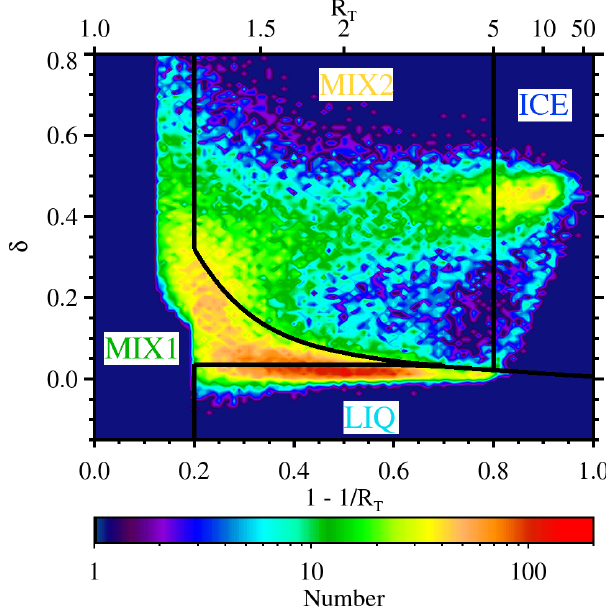
Fig. 2. Distribution of aerosol depolarization vs. normalized backscatter for the period 11–30 June 2008, showing the PSCs iden- tified by CALIOP at an altitude of 20–22km (near the MLS 32hPa retrieval level). The color bar indicates the number of observations per bin, with red hues being high and purple hues low. Solid lines mark the boundaries of the CALIOP PSC classification